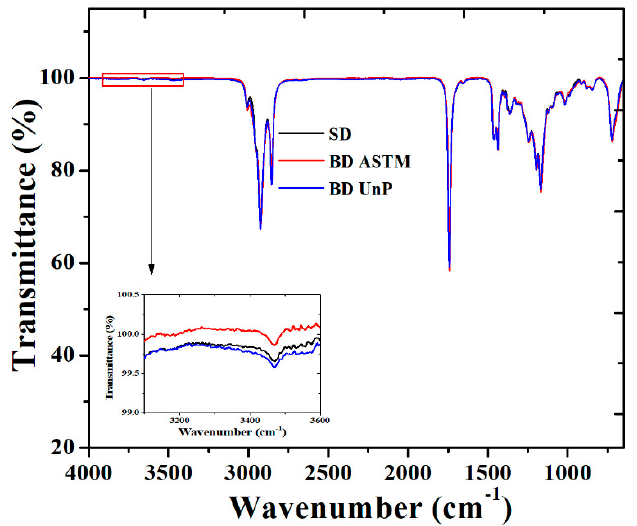
Figure 2. FTIR spectra of sawdust (SD), unpurified biodiesel (BD UnP), and ASTM purified biodiesel (BD ASTM) samples.